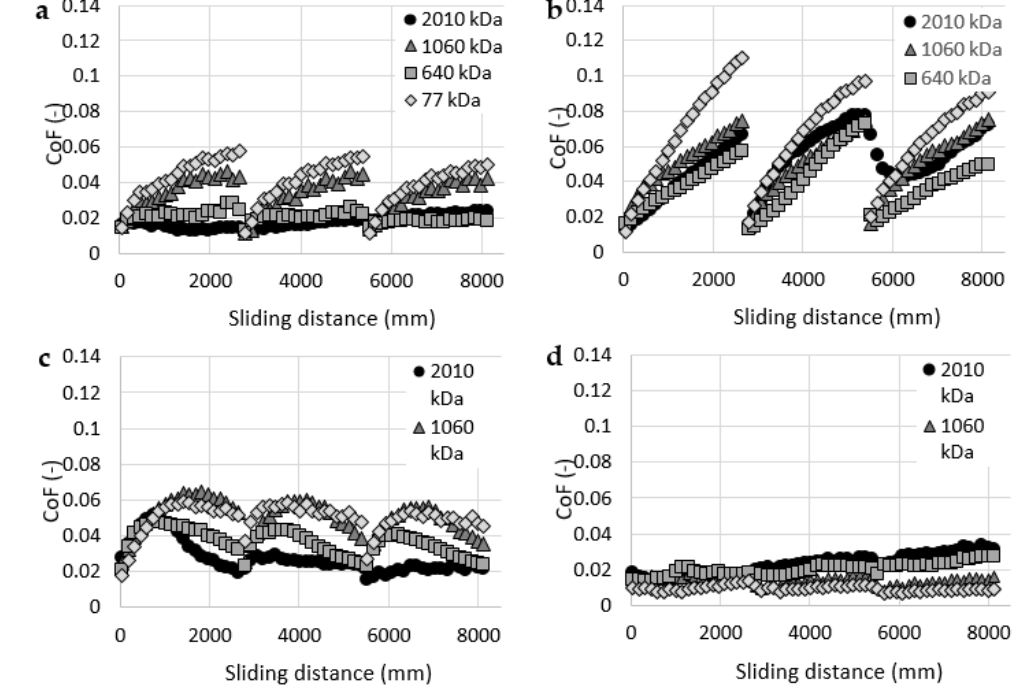
Figure 4. Coefficient of friction as a function of a sliding distance for hyaluronic acid (HA) solutions with a molecular weight of: ( a ) cartilage sample 1, ( b ) cartilage sample 2, ( c ) cartilage sample 3, ( d ) cartilage sample 4. Materials 2020 , 13 , x FOR PEER REVIEW